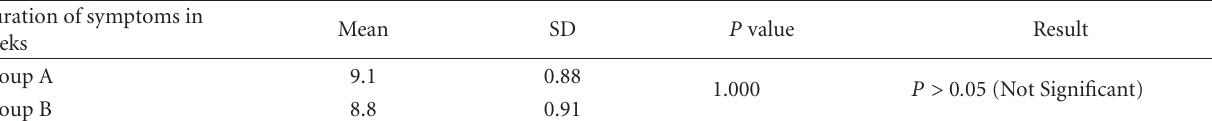
Table 3: Duration of symptoms (in weeks) in both groups.